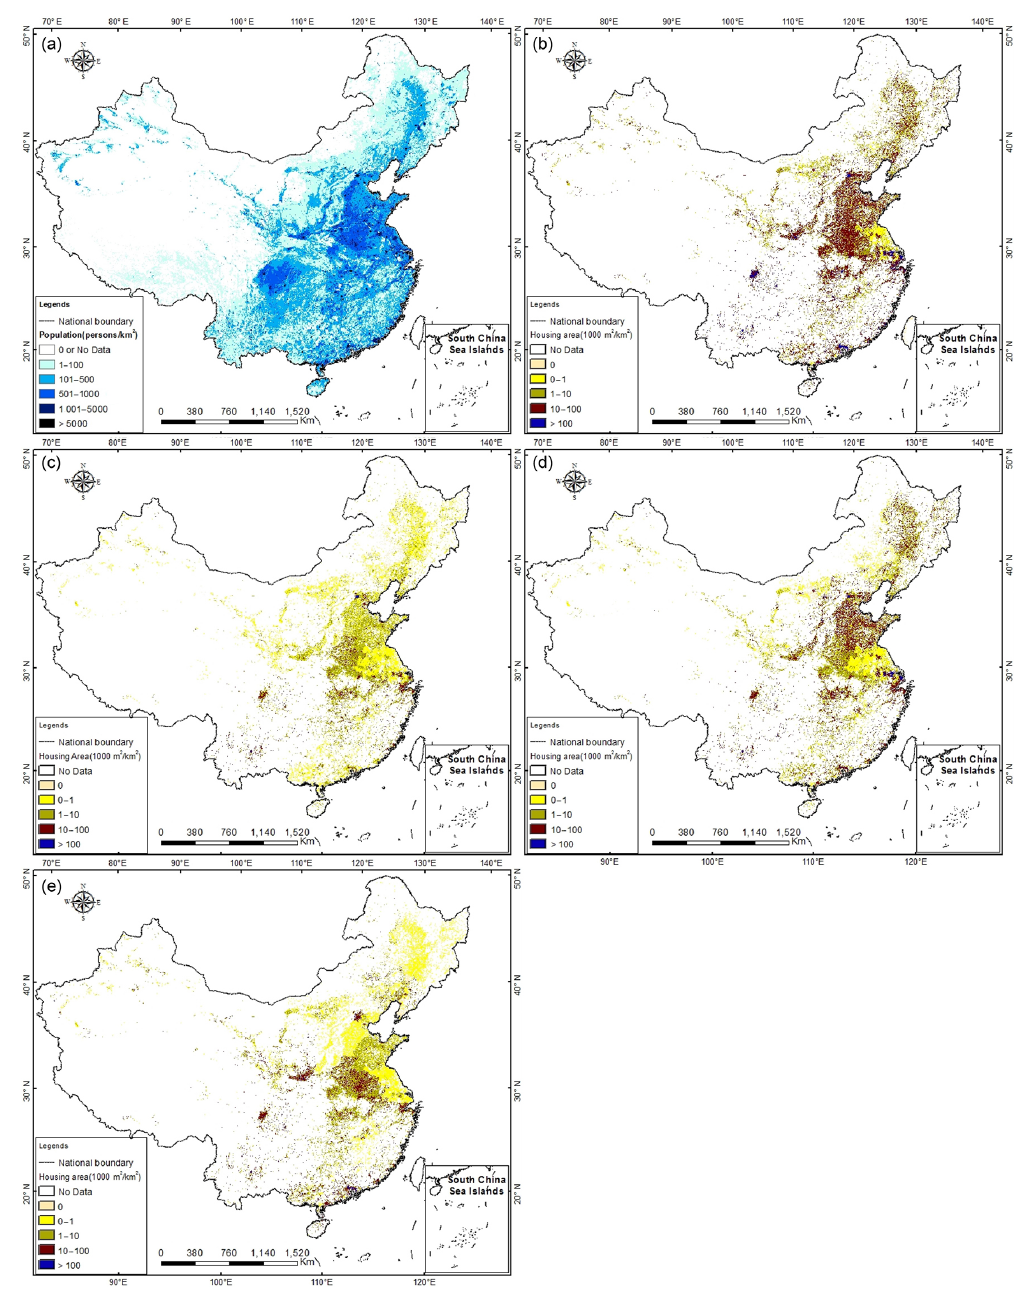
Figure 1. Exposure data in kilometre grid format: (a) population data; (b) B1 type buildings (steel and steel reinforced concrete structure); (c) B2 type buildings (brick masonry structure); (d) B3 type buildings (brick house, open-space structure with 24mm brick, cavity brick wall structure); (e) B4 type buildings (adobe houses mostly in Chinese rural villages).